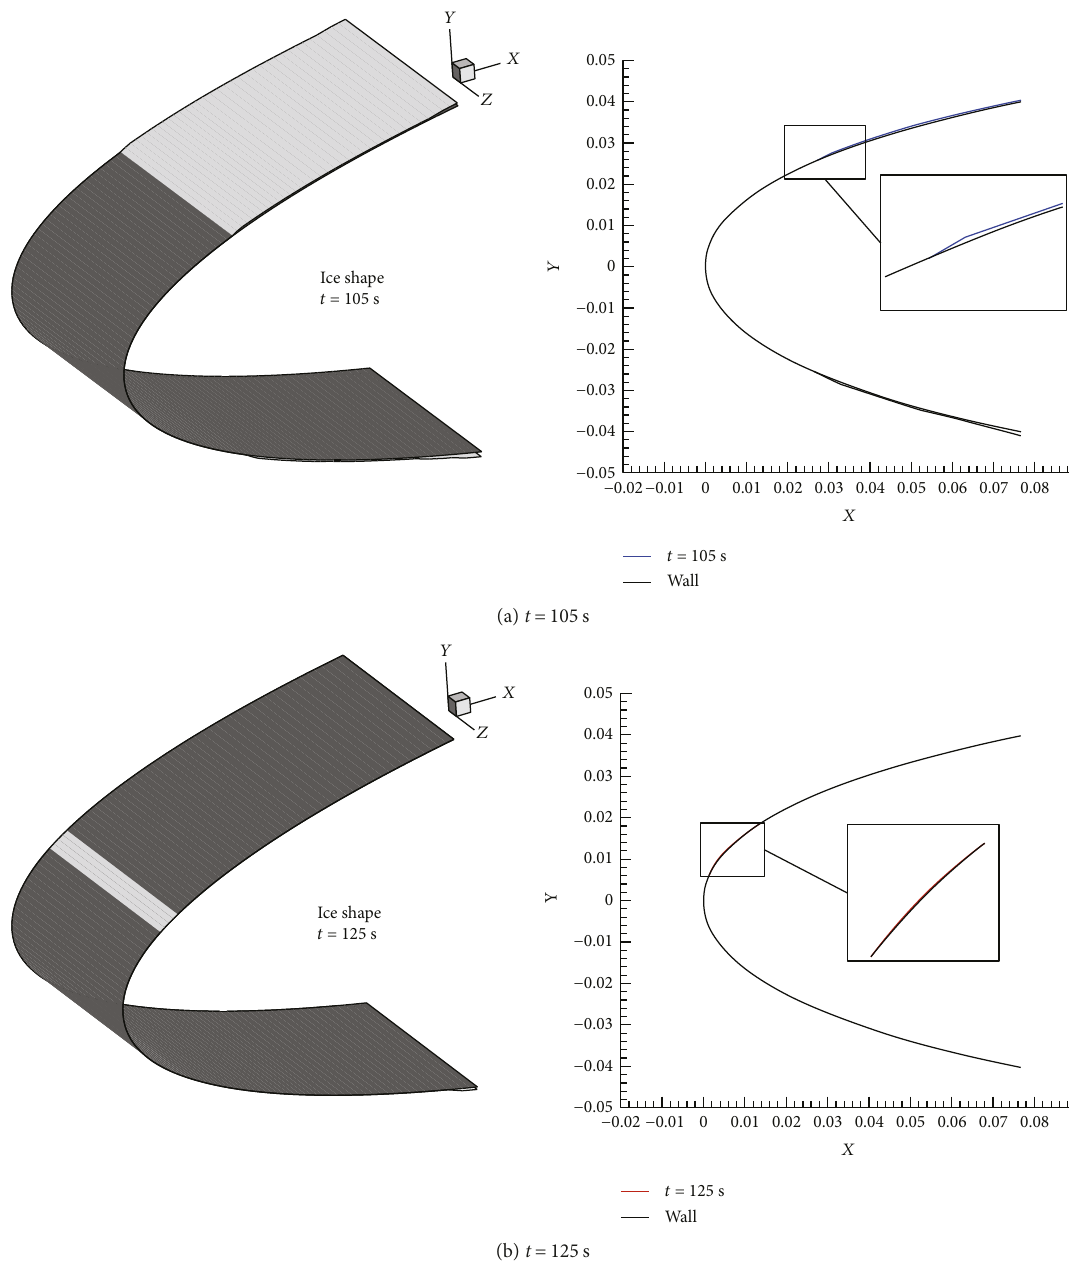
Figure 15: Simulated ice shape under altered heating